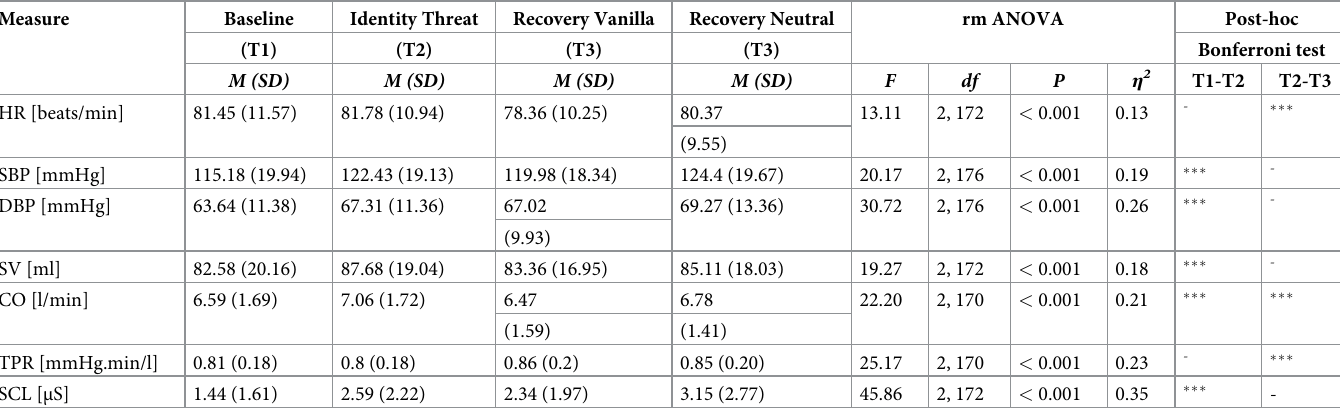
Table 3. Differences between experimental phases—Means (M), Standard Deviations (SD), results of Repeated Measures Analysis of Variance (rm ANOVA). Measure